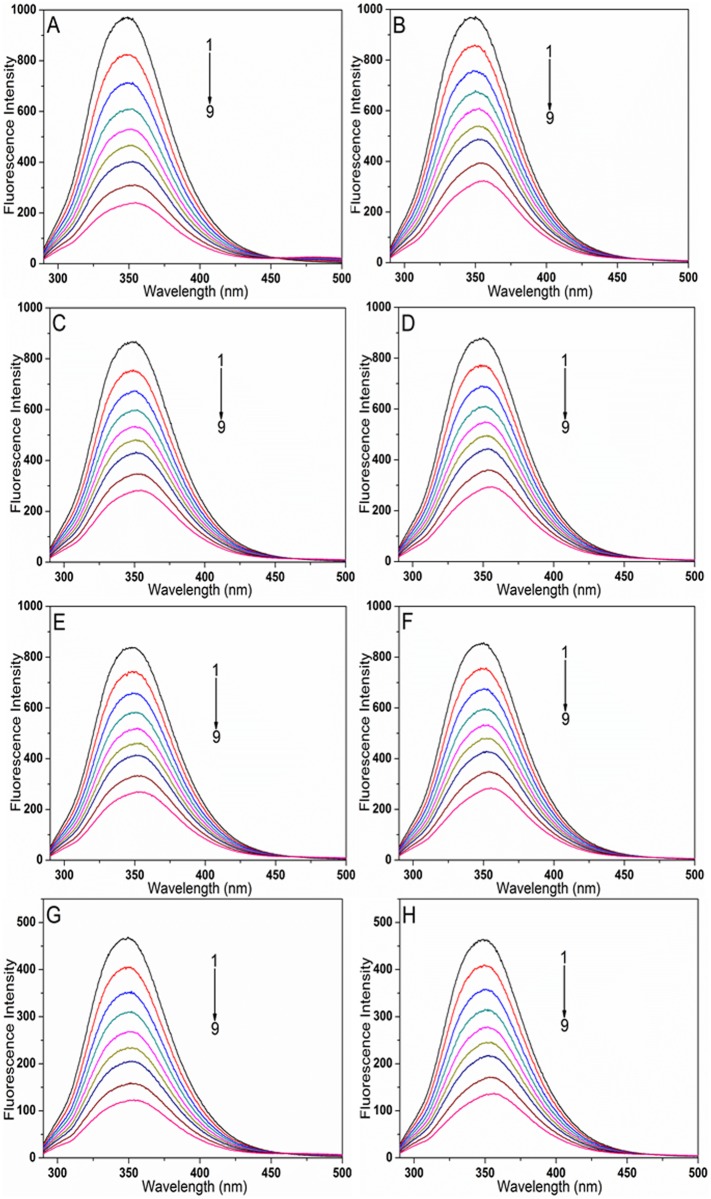
Fluorescence quenching spectra of BSA–drug systems with and without Au NPs at 298 K, λ
ex = 280 nm, CBSA = 5.0 × 10-6 mol L-1.(A) BSA-SAB system, the concentrations of SAB (1–9) were 0, 2.5, 5.0, 7.5, 10.0, 12.5, 15.0, 20.0, and 25.0 × 10-6 mol L-1, respectively. (B) BSA-RA system, the concentrations of RA (1–9) were 0, 2.5, 5.0, 7.5, 10.0, 12.5, 15.0, 20.0, and 25.0 × 10-6 mol L-1, respectively. (C) BSA-SAB-Au4 system, CAu4 = 10.0 × 10-11 mol L-1, the concentrations of SAB (1–9) were 0, 2.5, 5.0, 7.5, 10.0, 12.5, 15.0, 20.0, and 25.0 × 10-6 mol L-1, respectively. (D) BSA-RA-Au4 system, CAu4 = 10.0 × 10-11 mol L-1, the concentrations of RA (1–9) were 0, 2.5, 5.0, 7.5, 10.0, 12.5, 15.0, 20.0, and 25.0 × 10-6 mol L-1, respectively. (E) BSA-SAB-Au3 system, CAu3 = 10.0 × 10-11 mol L-1, the concentrations of SAB (1–9) were 0, 2.5, 5.0, 7.5, 10.0, 12.5, 15.0, 20.0, and 25.0 × 10-6 mol L-1, respectively. (F) BSA-RA-Au3 system, CAu3 = 10.0 × 10-11 mol L-1, the concentrations of RA (1–9) were 0, 2.5, 5.0, 7.5, 10.0, 12.5, 15.0, 20.0, and 25.0 × 10-6 mol L-1, respectively. (G) BSA-SAB-Au2 system, CAu2 = 10.0 × 10-11 mol L-1, the concentrations of SAB (1–9) were 0, 2.5, 5.0, 7.5, 10.0, 12.5, 15.0, 20.0, and 25.0 × 10-6 mol L-1, respectively. (H) BSA-RA-Au2 system, CAu2 = 10.0 × 10-11 mol L-1, the concentrations of RA (1–9) were 0, 2.5, 5.0, 7.5, 10.0, 12.5, 15.0, 20.0, and 25.0 × 10-6 mol L-1, respectively.